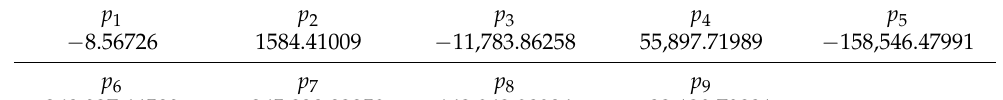
Figure 6. Original and fitting curves for flow-stress of S280 steel at a deformation temperature of 1150 °C and strain rate of 1 s − 1. Table 1. Flow-stress fitting curve equation coefficients for S280 steel at a deformation temperature of 1150 °C and strain rate of 1 s − 1.